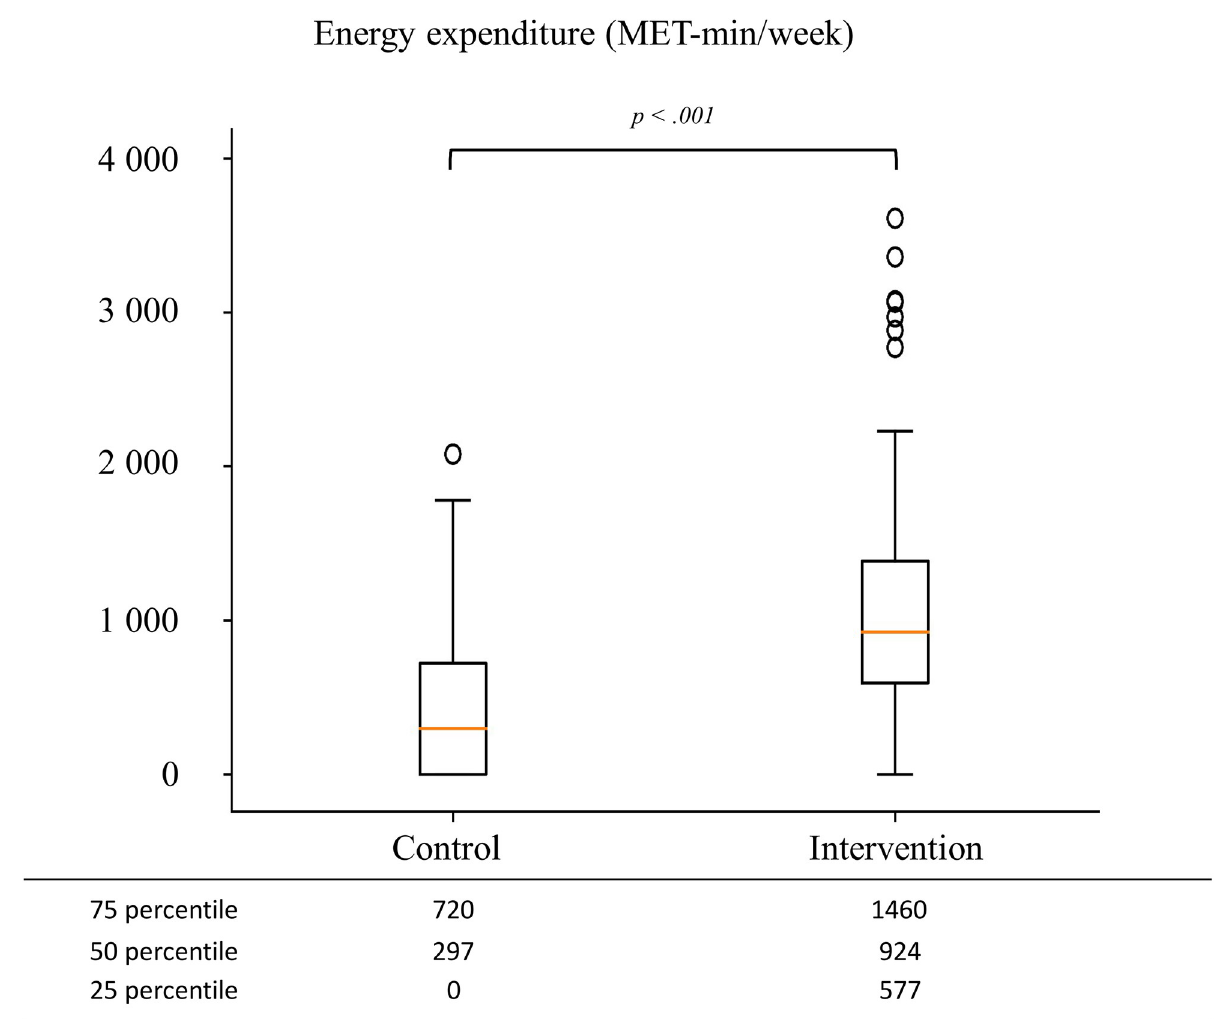
Fig 2. Physical activity-related energy expenditure in the intervention and control groups.